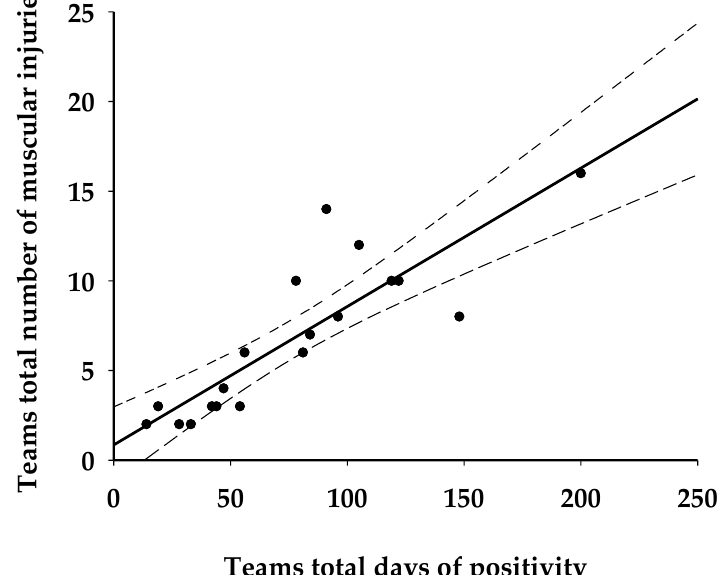
Figure 1. Relationship between teams’ total days of positivity and teams’ total number of injuries (r = 0.86; CI 95% 0.66 to 0.94; p < 0.0001). Table 2. Comparisons between seasons 2016–2017, 2017–2018, 2018–2019, and 2020–2021 with respect to average articular and muscular number of injuries of all Serie A teams. Values are given as mean ± SD (* p < 0.001, statistically different from season 2016-2017, 2017-2018; # p < 0.01 statistical different from season 2018–2019).